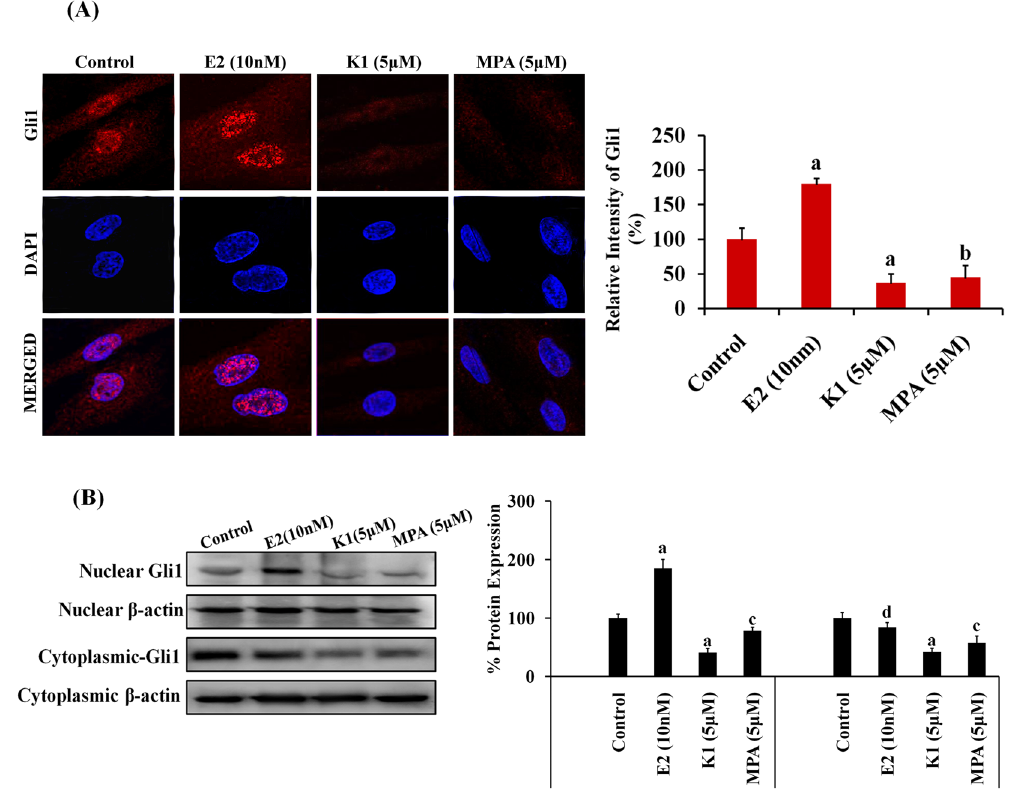
Figure 3. Estrogen up-regulates the expression of Gli1 and its nuclear localization while K1 or MPA counteracts its expression in primary human endometrial hyperplasial cells. ( A ) Representative micrographs (Left panel) demonstrating the nuclear localization of Gli1 via confocal microscopy to detect the effect of E2 or K1 or MPA in primary human EH cells. EH cells were treated with vehicle or E2 (10 nM) or K1 (5 µ M) or MPA (5 µ M) for 24 h. Cells were fixed, permeabilized, incubated with Gli1 antibody as described in ‘materials and methods’ section. Experiments were repeated at least three times (independent samples). The fluorescence intensity was determined by LSM Image Browser software (Right panel). Values are expressed as mean ± SEM, n = 3 (independent samples). p values: a p < 0.001, b p < 0.01 vs. control. ( B ) Representative western blots showing the nuclear and cytosolic Gli1 expression in EH cells. Nuclear and cytosolic proteins were extracted following manufacturer’s instructions and subjected to western blotting using anti-Gli1 antibody. β -actin was used as internal loading control. Densitometric data shown as % change in protein expression levels. Values are expressed as mean ± SEM, n = 3 (independent samples). p values: a p < 0.001, c p < 0.05 and d p > 0.05 vs.